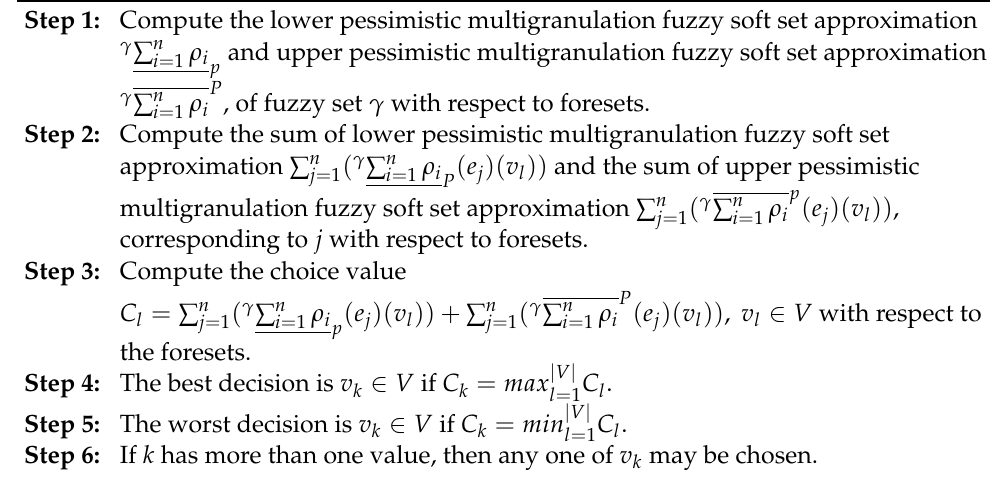
Algorithm 2: An algorithm for the approach to a decision-making problem with respect to the foresets is presented in the following.